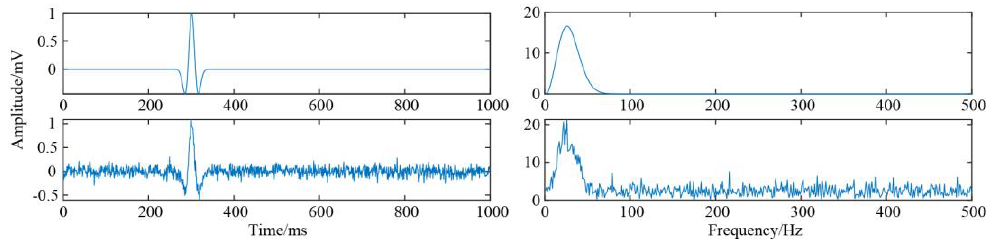
Figure 1. Ricker waveform, noisy Ricker waveform, and their spectrums.